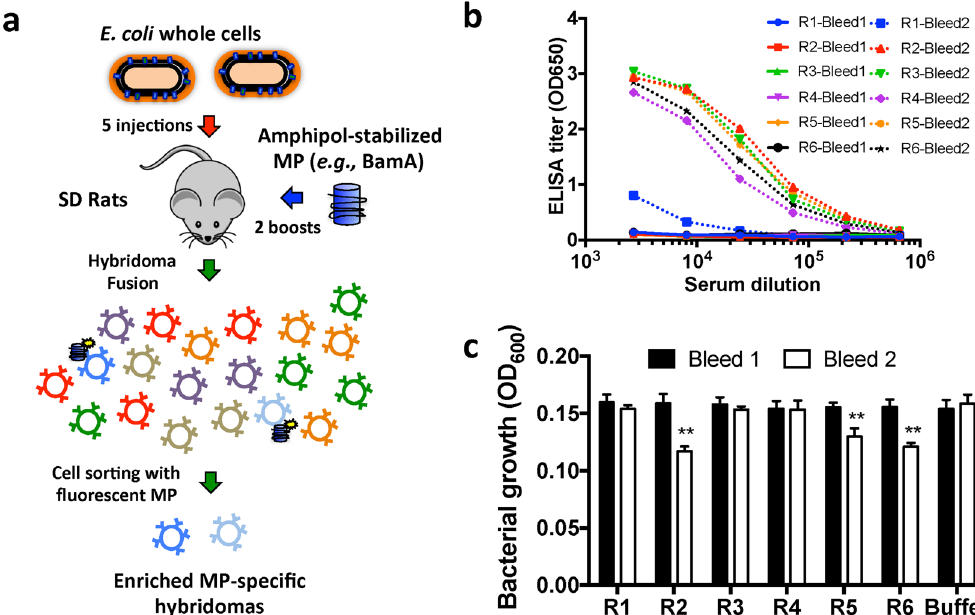
Figure 2. Combining native and recombinant BamA formats enables discovery of growth inhibitory pAbs. ( a ) Schematic of “targeted boost-and-sort” strategy in which Sprague-Dawley (SD) rats are initially primed with K12 bacteria (red arrow) followed by two boosts with the recombinant amphipol-BamA (blue arrow). After subsequent cell fusion to generate hybridomas, fluorescently-labeled BamA is used to single cell sort BamA + hybridomas to generate a final enriched panel. ( b ) pAb ELISA titers using purified pAbs dramatically improve post-protein boost (dashed line) compared to pre-boost (solid line). ( c ) pAbs from three rats (R2, R5, and R6) reduce growth of Δ waaD E . coli as measured by OD600 density only after protein boost (white vs. black box). Growth differences observed for bleed 2 in R2, R5, and R6 were statistically significant compared to buffer controls (n = 3, p <